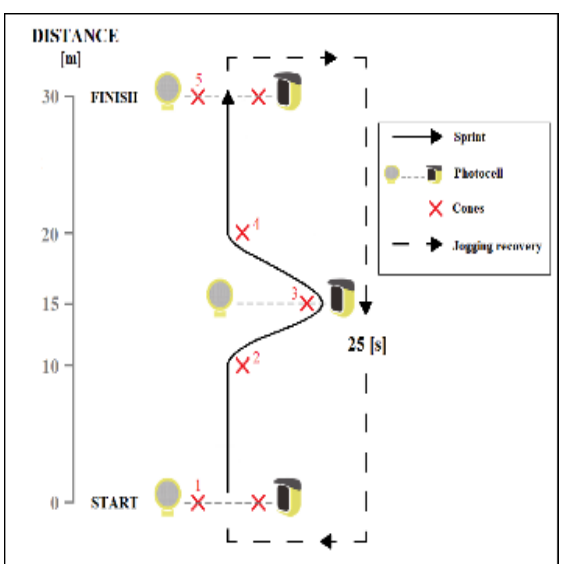
Figure 1. The curved sprint test. A player started from net N.1, with one leg placed on the starting line and the other leg placed behind the starting line. The player started sprinting to net N.5 once the examinator signaled the start. Right after the start, the player sprinted to the second cone, where he changed direction by circling the #2 cone from the outside and sprinted to the #3 cone. After circling the #3 cone from the outside, the player sprinted to the finishing line. Photocells used for measuring time were placed 1 m high and were located on the starting line, 15 m from the starting line, and on the finishing line. After the player finished the sprint, he returned to the starting line to start again. The player ran a total of 7 sprints with 25 s of active rest (low-intensity running). After the player finished every sprint, he had 25 s to return to the starting line. Then, the examinator counted down the last 3 s and measured both the total time as well as the time taken on singular distances.